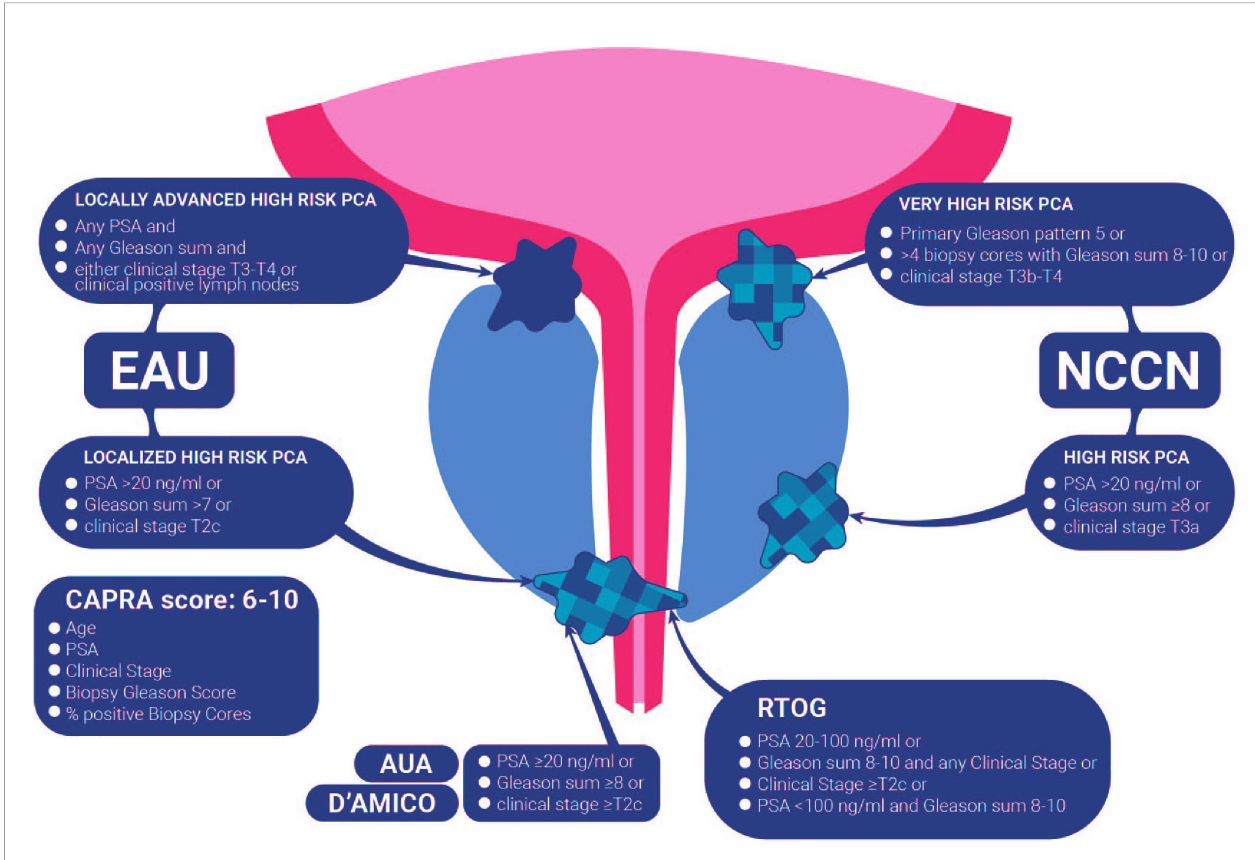
FIGURE 1 | Summary of the currently available classi fi cations for high-risk prostate